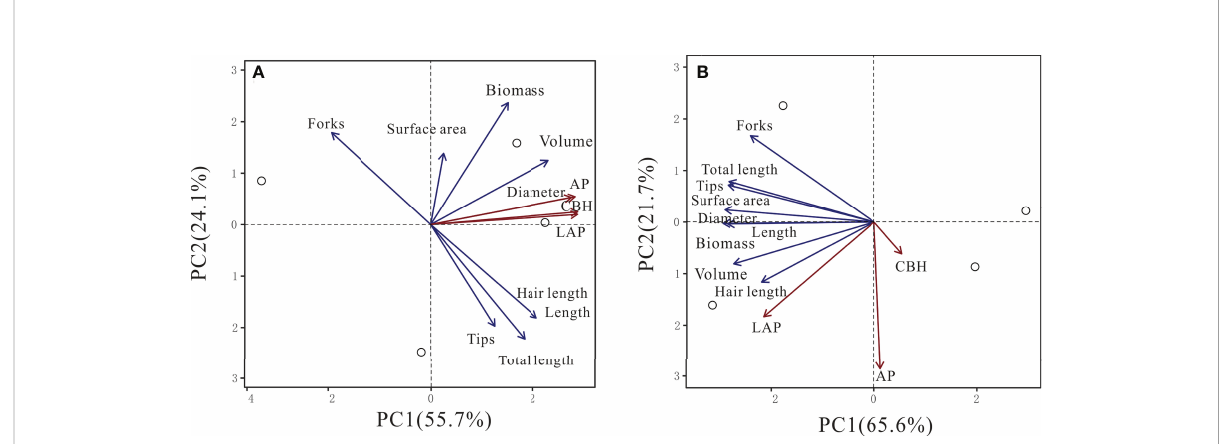
FIGURE 5 Principal component analysis (PCA) of cellobiohydrolase (CBH), leucine-aminopeptidase (LAP), and acid phosphomonoesterase (AP) activities in relationship with root traits in beech (A) and spruce (B) rhizosphere. (N = 4).